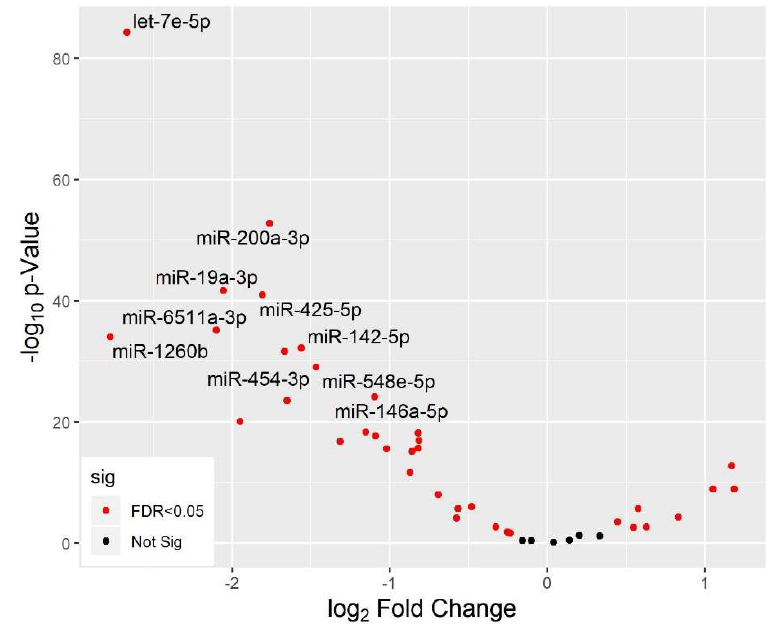
Figure 3. Volcano plots of differential miRNA expression between newborns and 7-year-old children. The majority of miRNAs had negative log 2 fold-change values, showing lower expression in newborns compared to 7-year-old children.